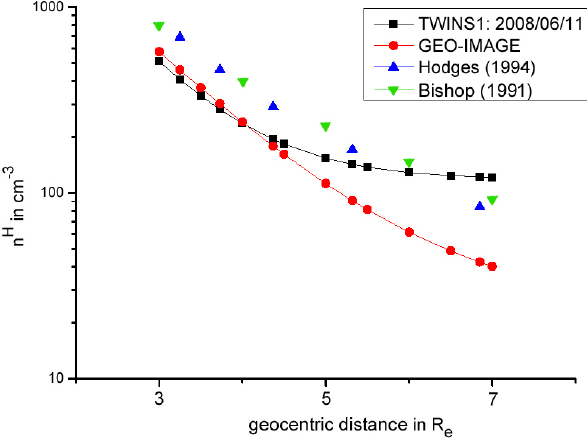
Fig. 4. Comparison of different H-density profiles: exponential model TWINS1 (black), H-density profile ( φ = 90 ◦ ) by Østagaard and Mende (2003) (red), H-density profile ( φ = 90 ◦ ) by Bishop (1991) (green) and averaged equatorial profile (Solstice, 10.7cm radioflux=80) by Hodges (1994) (blue).